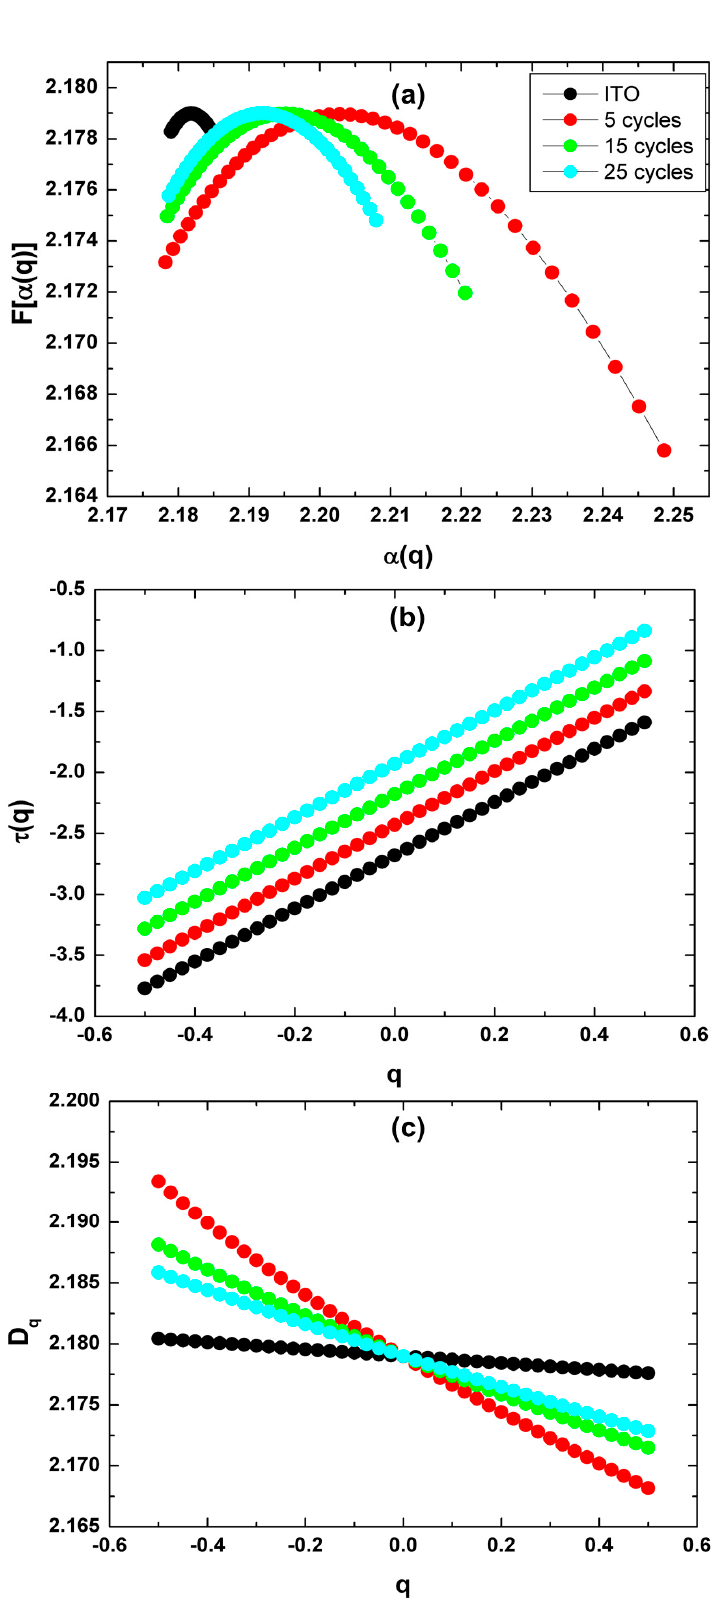
Figure 5. ( a ) Generalized dimensions and ( b ) the mass exponent τ ( q ) as a function of the order of moments for the thin film surfaces. For better visualization, the curves referring to τ ( q ) were shifted in by − 0.5, − 0.25, 0.00, and +0.25 for ITO, 5, 15, and 25 cycles, respectively. ( c ) Multifractal singularity curve of the ITO and POEA films.